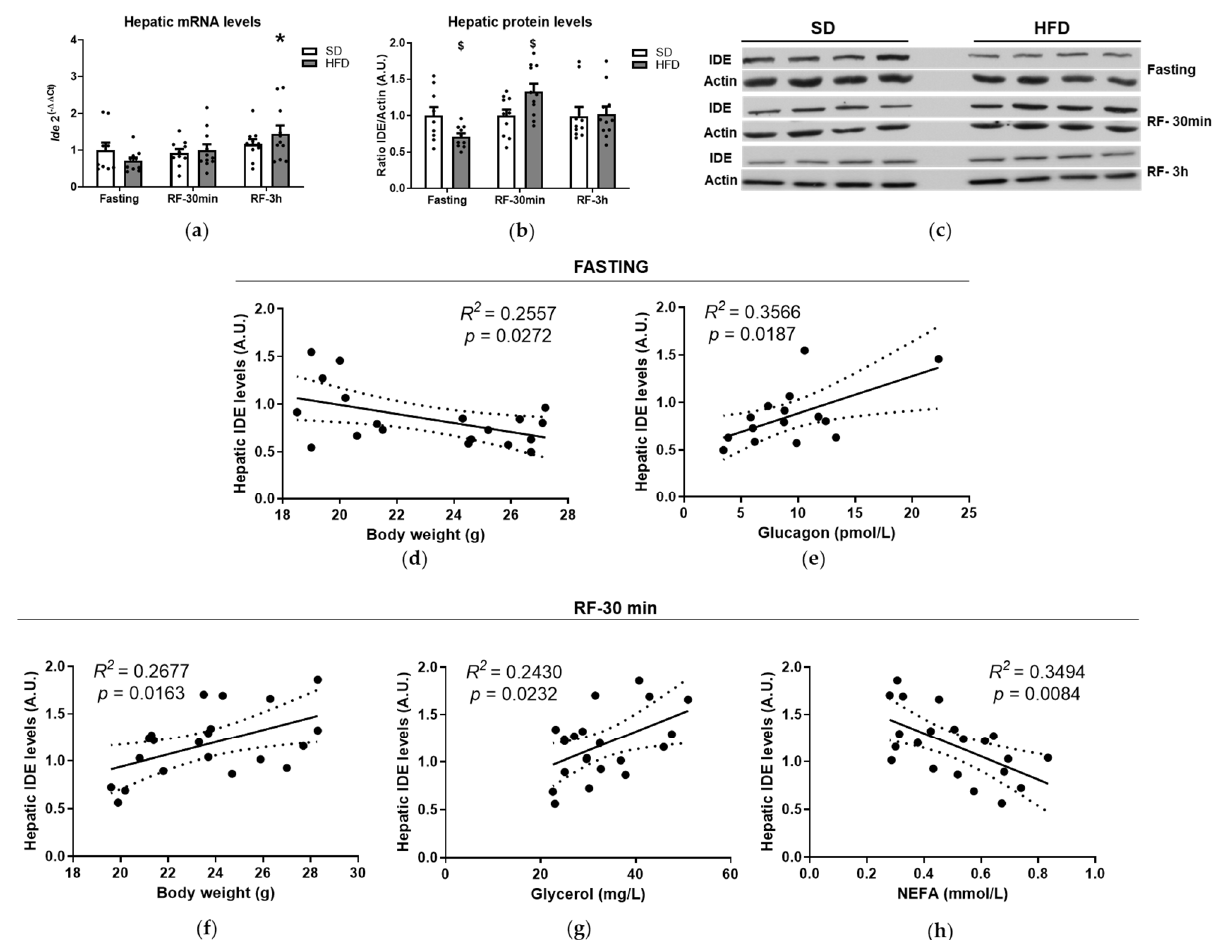
Figure 1. Transcriptional and posttranscriptional regulation of hepatic IDE. ( a ) Transcriptional regulation of Ide . Total mRNA was isolated and quantified from liver tissues of mice fed an SD or HFD during fasting or refeeding conditions. Data are the means ± SEM. N = 9–11 mice per condition. * p < 0.05 vs. fasting by ANOVA. ( b ) Regulation of IDE protein levels. Lysates from livers of mice fed an SD or HFD, during fasting or refeeding conditions, were resolved by Western blots and quantified by densitometric analyses using full blots (Appendix A, Figure A2a). Data were then plotted for each nutritional status and diet. Data are the means ± SEM. N = 9–11 mice per condition. $ p < 0.05 vs. SD by ANOVA. ( c ) Representative image illustrating hepatic IDE levels showed in “panel b”. ( d – h ) Regression analyses. Bivariate analyses were performed using data from mice fed an SD and HFD during fasting or refeeding conditions. Correlations between fasting hepatic IDE protein levels and body weight ( d ), and glucagon ( e ). Correlations between hepatic IDE under refeeding (30 min) conditions and body weight ( f ), glycerol ( g ), and NEFA ( h ). The R 2 and the statistical significances ( p ) values are indicated in the figure.